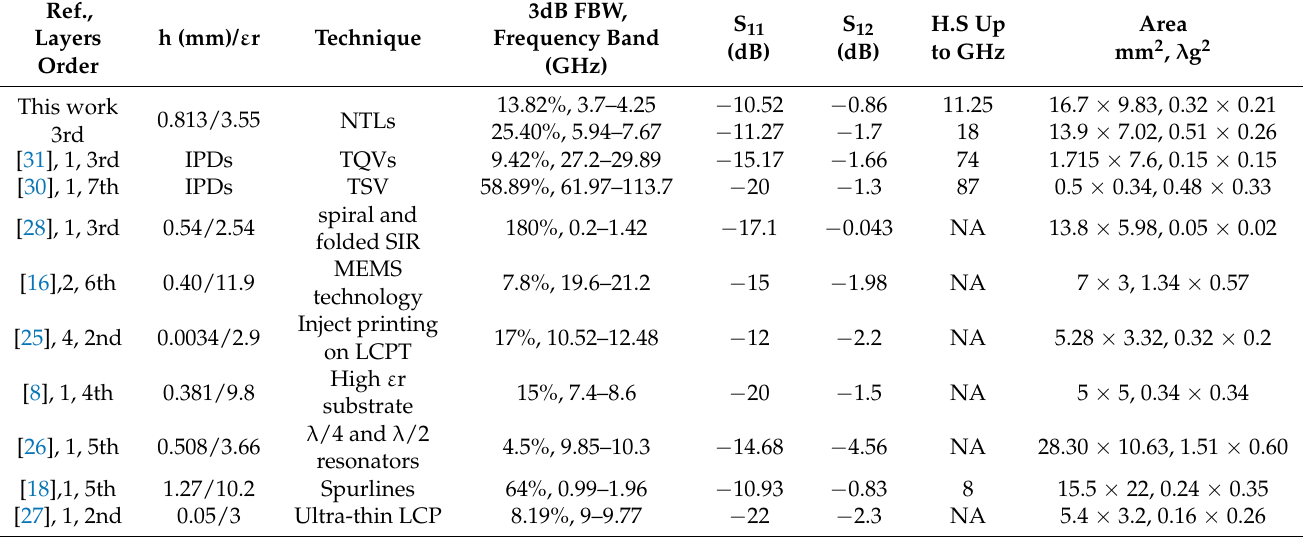
Table 4. A comparison to other works in the literature at different frequency bands.